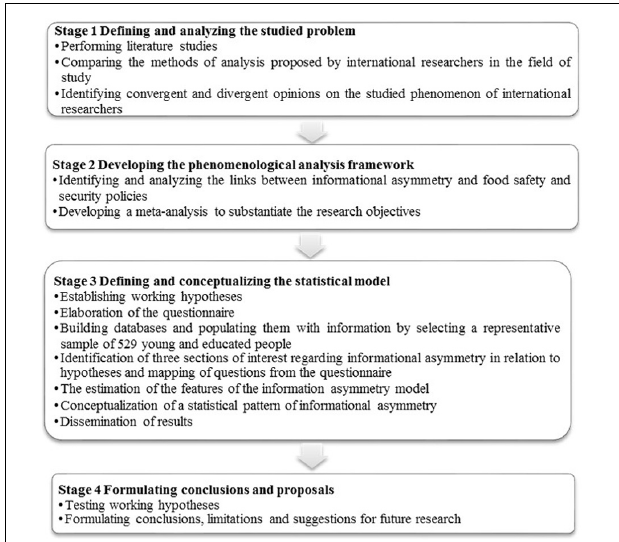
FIGURE 2 | Mapping of the research. Source: Author’s